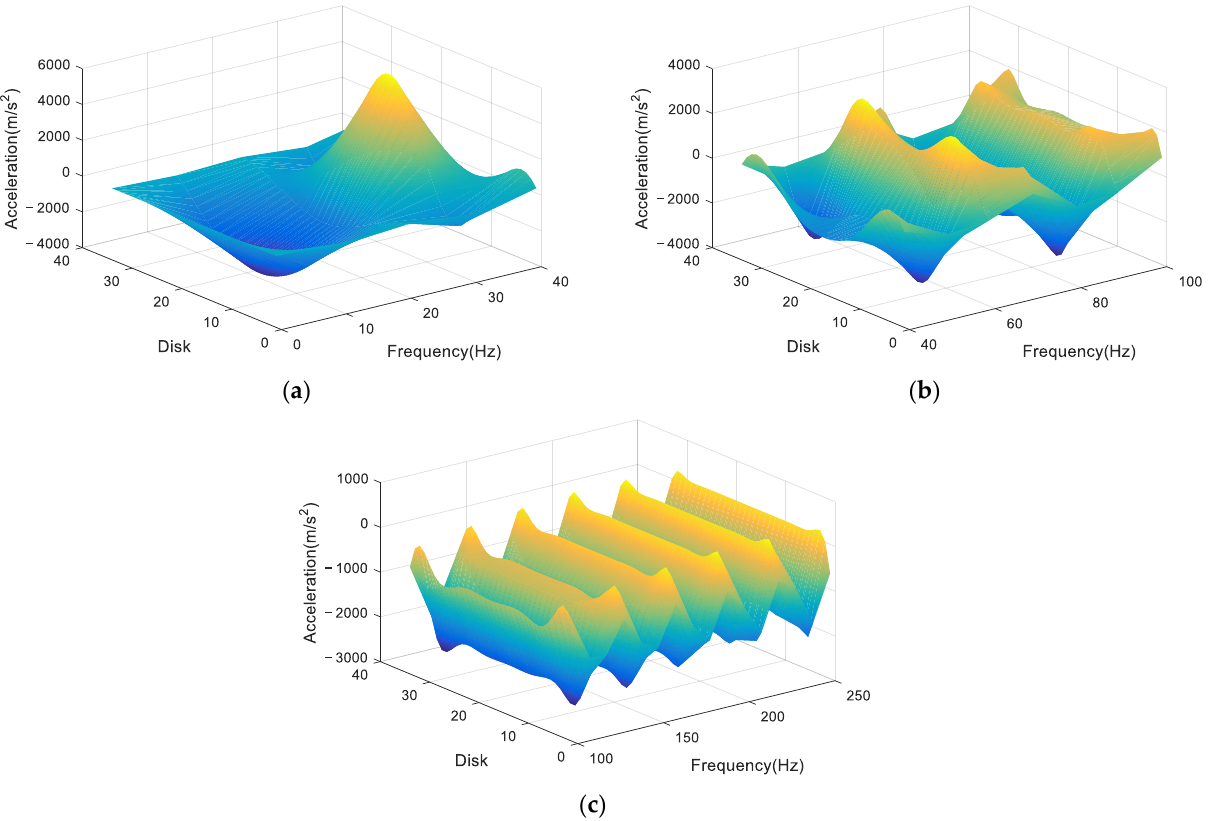
Figure 6. Acceleration of each disk at 0 – 250 Hz. ( a ) Acceleration of Each disk at 0 – 40 Hz; ( b ) 40 – 100 Hz; and ( c ) 100 – 250 Hz.